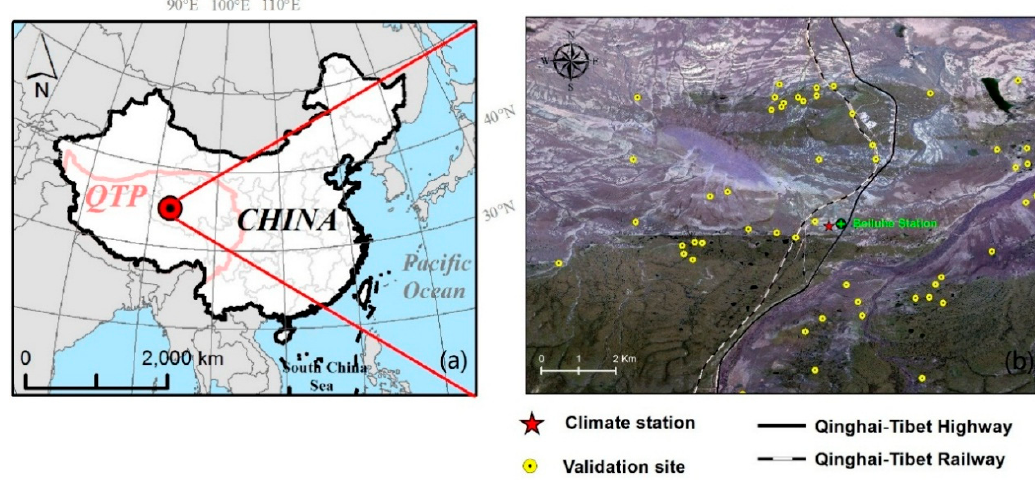
Figure 1. The location of the study area: ( a ) The Beiluhe basin in the central Qinghai-Tibet Plateau (QTP); ( b ) Gao fen-1 satellite image (2.0 m resolution) of the study area and the locations of the climate station and the validation sites.